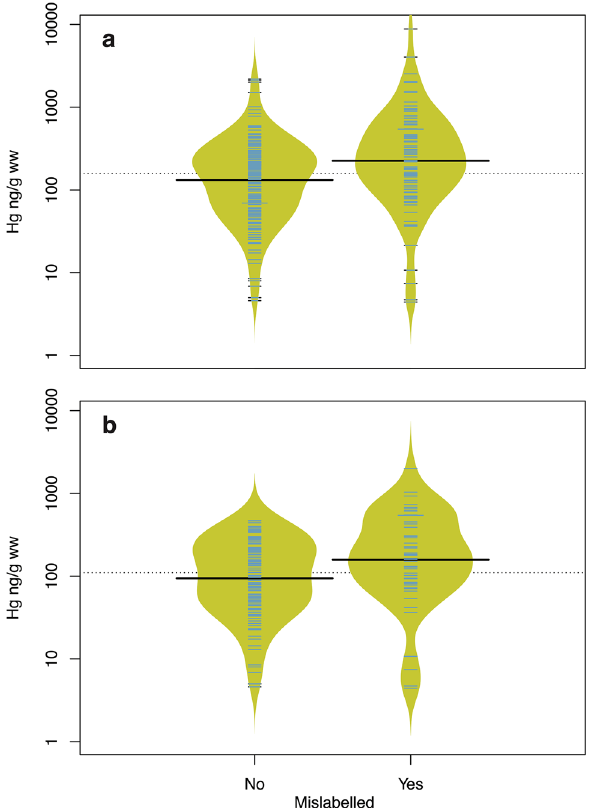
Figure 5. Beanplots comparing mercury concentration of samples labelled correctly (No) and mislabelled (Yes). ( a ) Total mercury concentration for all samples (331 Hg ng/g ww, n = 271). ( b ) Total mercury concentrations for all samples excluding sharks and billfishes (194 Hg ng/g ww, n = 171). Each “bean” shows the distribution of mercury concentrations in Hg ng/g ww. The y-axis is log transformed. The black lines in each bean indicate the average mercury concentration for each group. Each blue horizontal line represents a sample. The dotted line indicates the overall average mercury concentration for the samples included in the